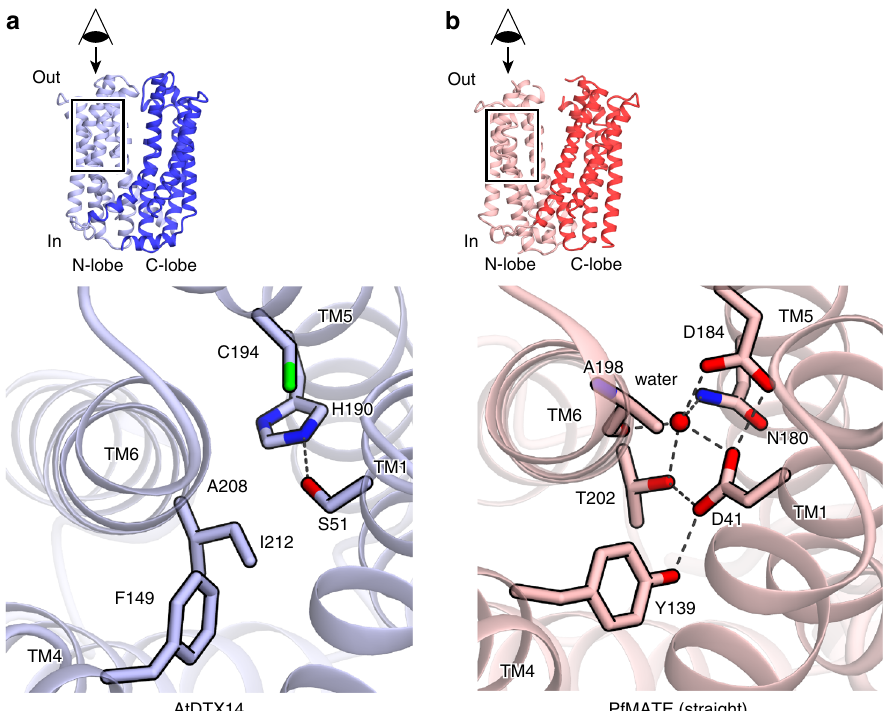
Fig. 6 Structural comparison between the N-lobes of AtDTX14 and PfMATE. a , b Close-up views of the N-lobe of AtDTX14 ( a ) and that of PfMATE ( b